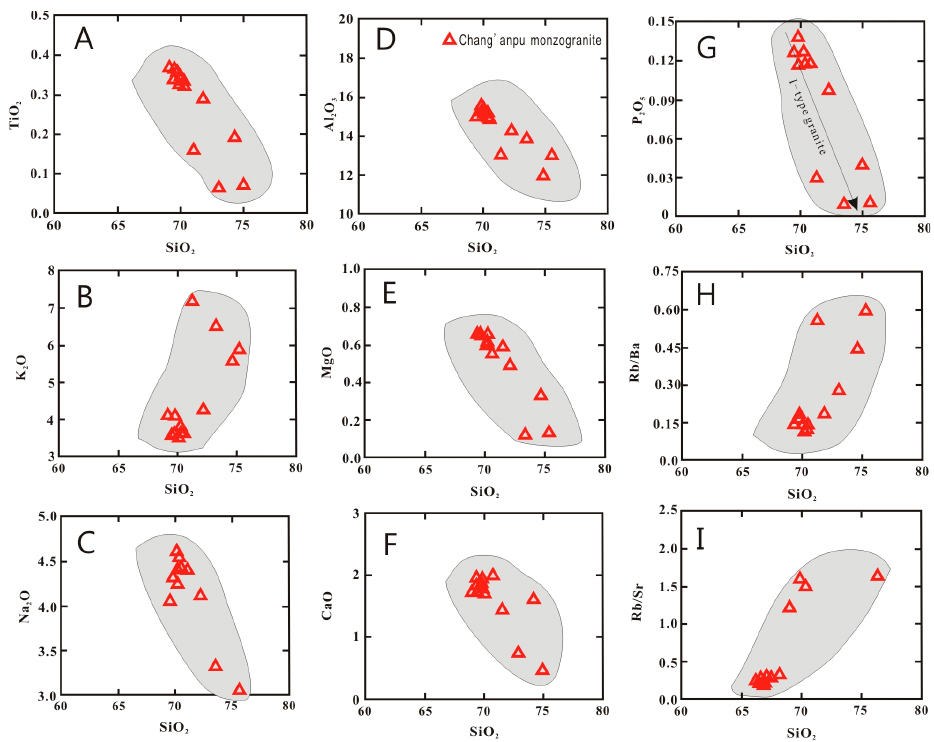
Figure 7. Harker variation diagrams for the monzogranite. TiO 2 ( A ), K 2 O ( B ), Na 2 O ( C ), Al 2 O 3 ( D ), MgO ( E ), CaO ( F ), P 2 O 5 ( G ), Rb/Ba ( H ), and Rb/Sr ( I ) versus SiO 2